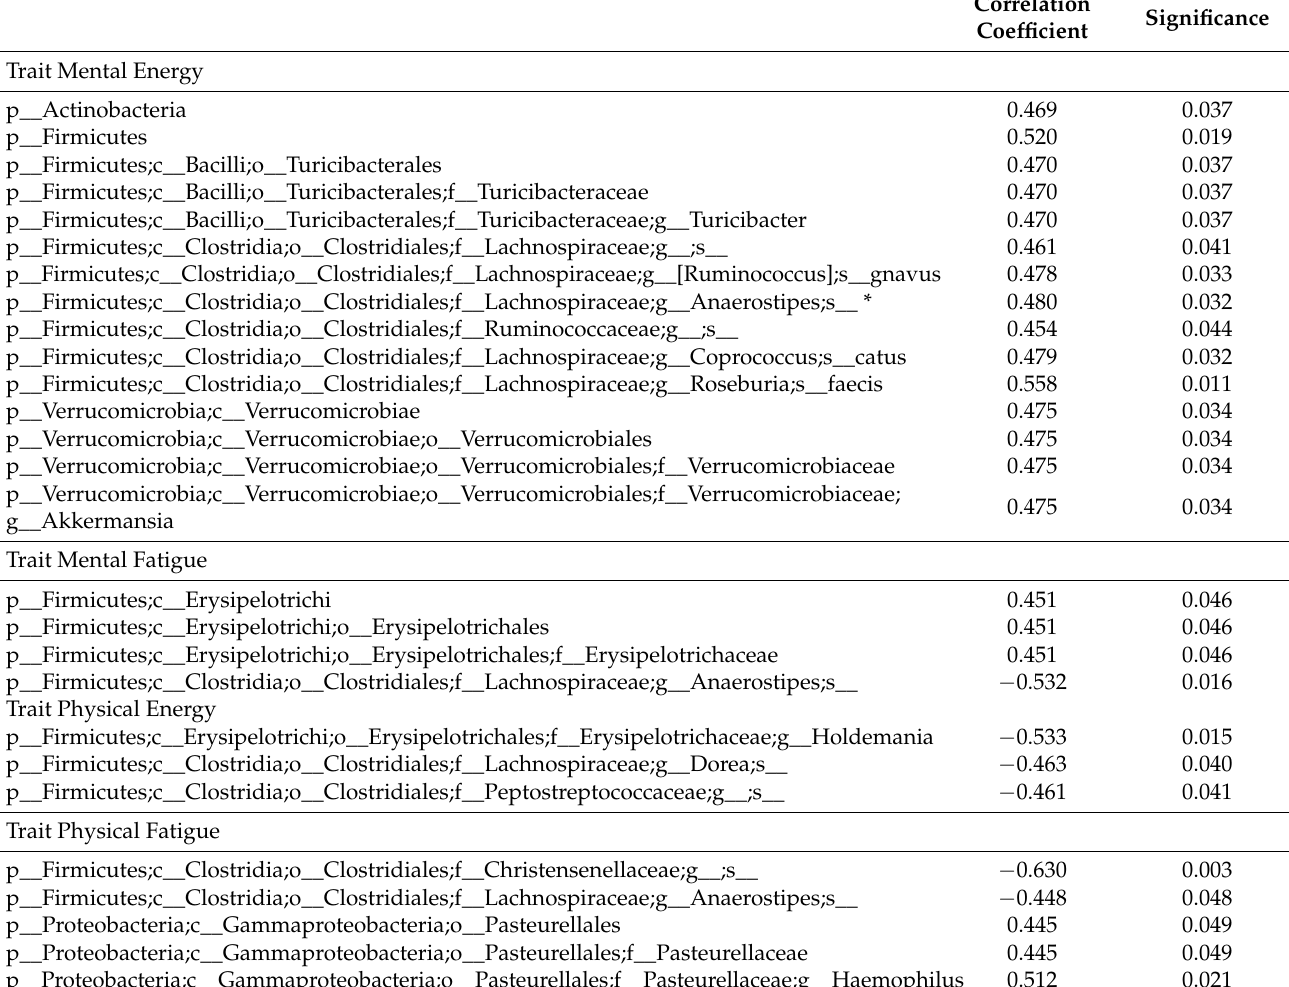
Table 1. Bacteria taxa significantly correlated with specific traits. Same colored bacteria names correlate with more than one